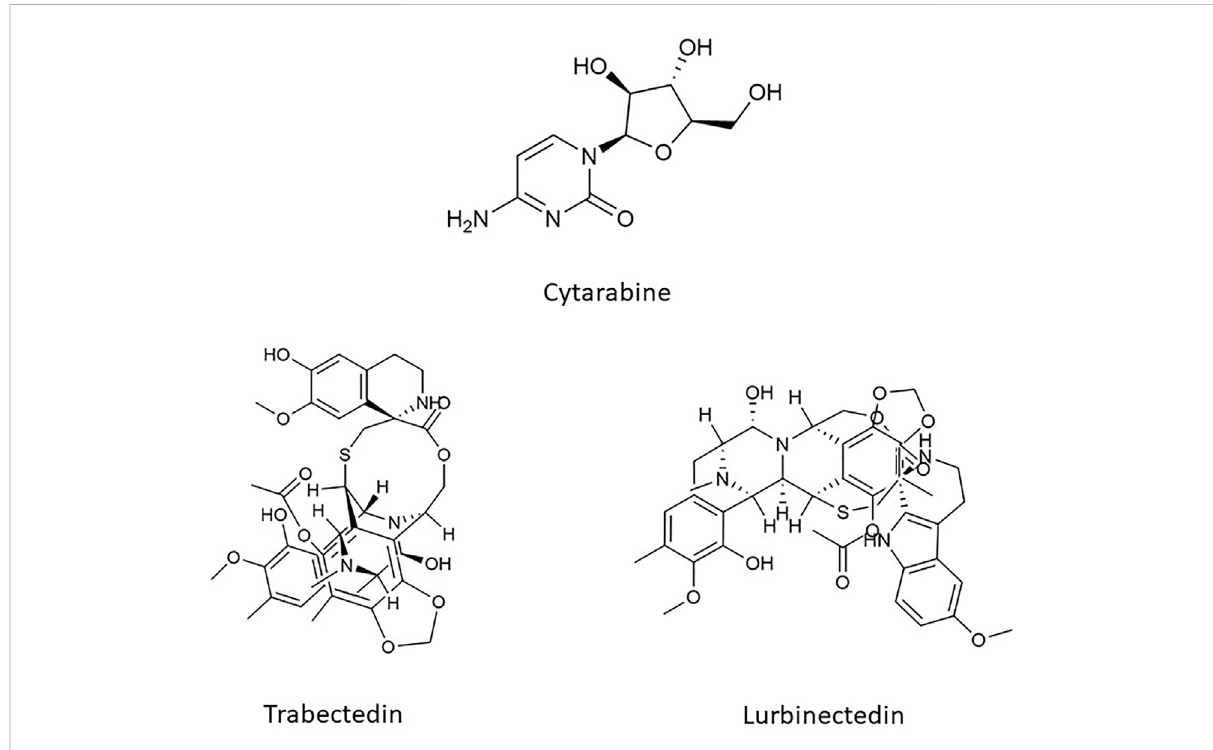
FIGURE 3 Chemical structure of Cytarabine, Trabectedin, and